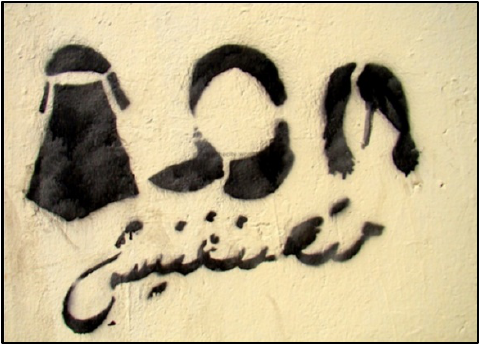
Figure12. Don’t label me graffiti